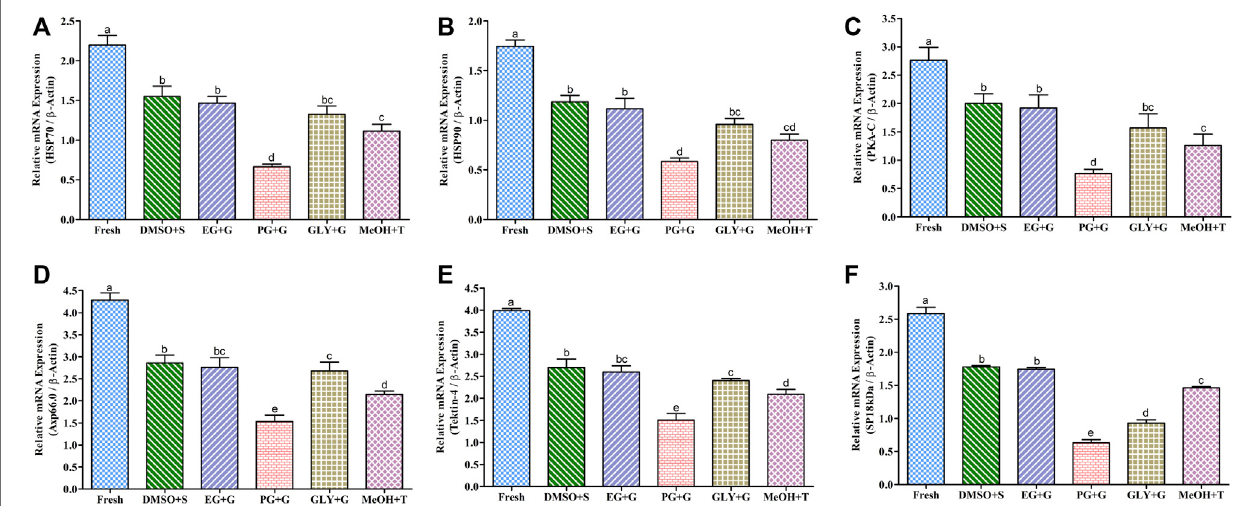
FIGURE 7 | mRNA content of motility and fertility-associated gene in saccharide-supplemented cryopreserved sperm of Paci fi c abalone (n = 5). (A) Heat shock protein 70 (HSP70) mRNA content. (B) Heat shock protein 90 (HSP90) mRNA content. (C) cAMP-dependent protein kinase (PKA-C) mRNA content. (D) Axonemal protein 66.0 (Axp66.0) mRNA content. (E) Tektin-4 mRNA content. (F) Fertilization protein (SP18 kDa) mRNA content. mRNA content values were normalized against average Δ CT values of the control. DMSO + S: 8% dimethyl sulfoxide (DMSO) combined with 3% sucrose (S), EG + G: 8% ethylene glycol (EG) combined with 1% glucose (G), PG + G: 6% propylene glycol (PG) combined with 2% glucose (G), GLY + G: 2% glycerol combined with 3% glucose (G), and MeOH + T: 2% methanol (MeOH) combined with 4% trehalose (T). Signi fi cantly different levels ( p < 0.05) are denoted by different letters.